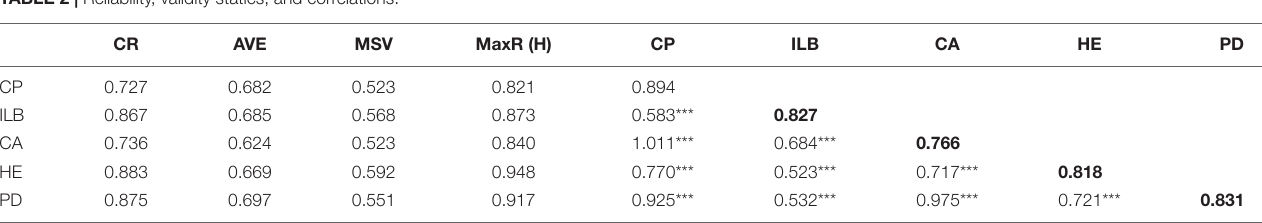
FIGURE 2 | Measurement model. CP, cultural performance; ILB, innovative learning behavior; CA, cultural adoption; HE, higher education; PD, personality development. TABLE 2 | Reliability, validity statics, and